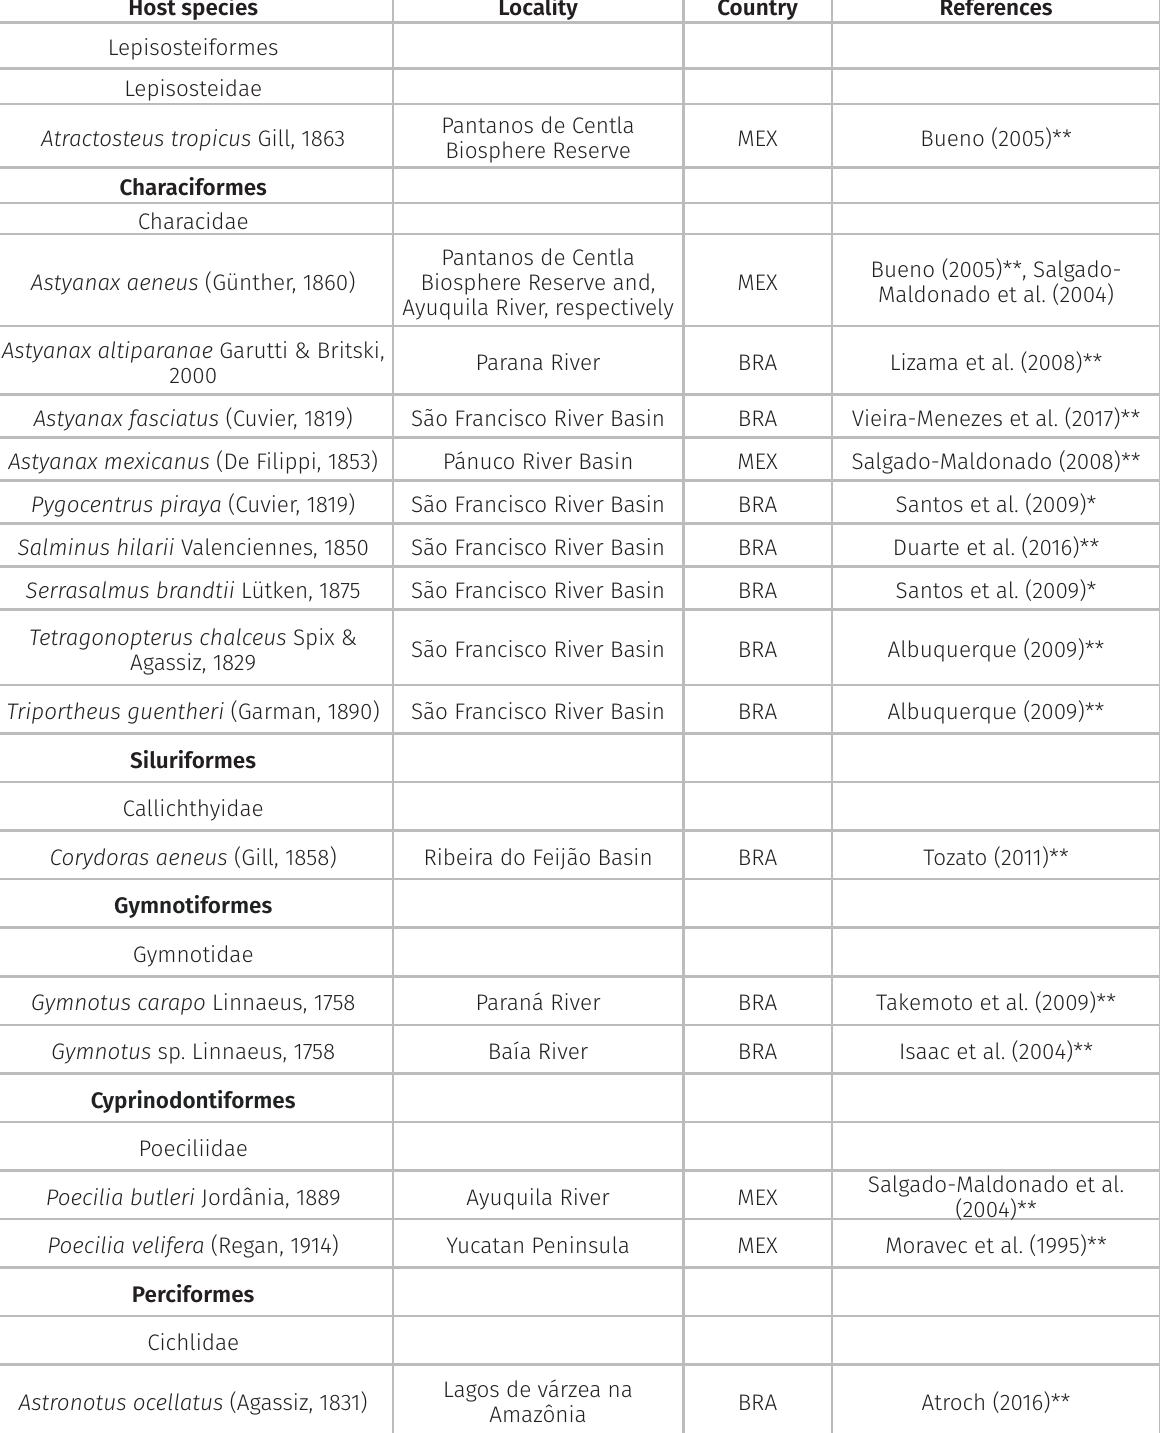
Table I. List of host species parasitized with larvae of the genus Spiroxys and geographical distribution. Abbreviations: MEX = Mexico and BRA =